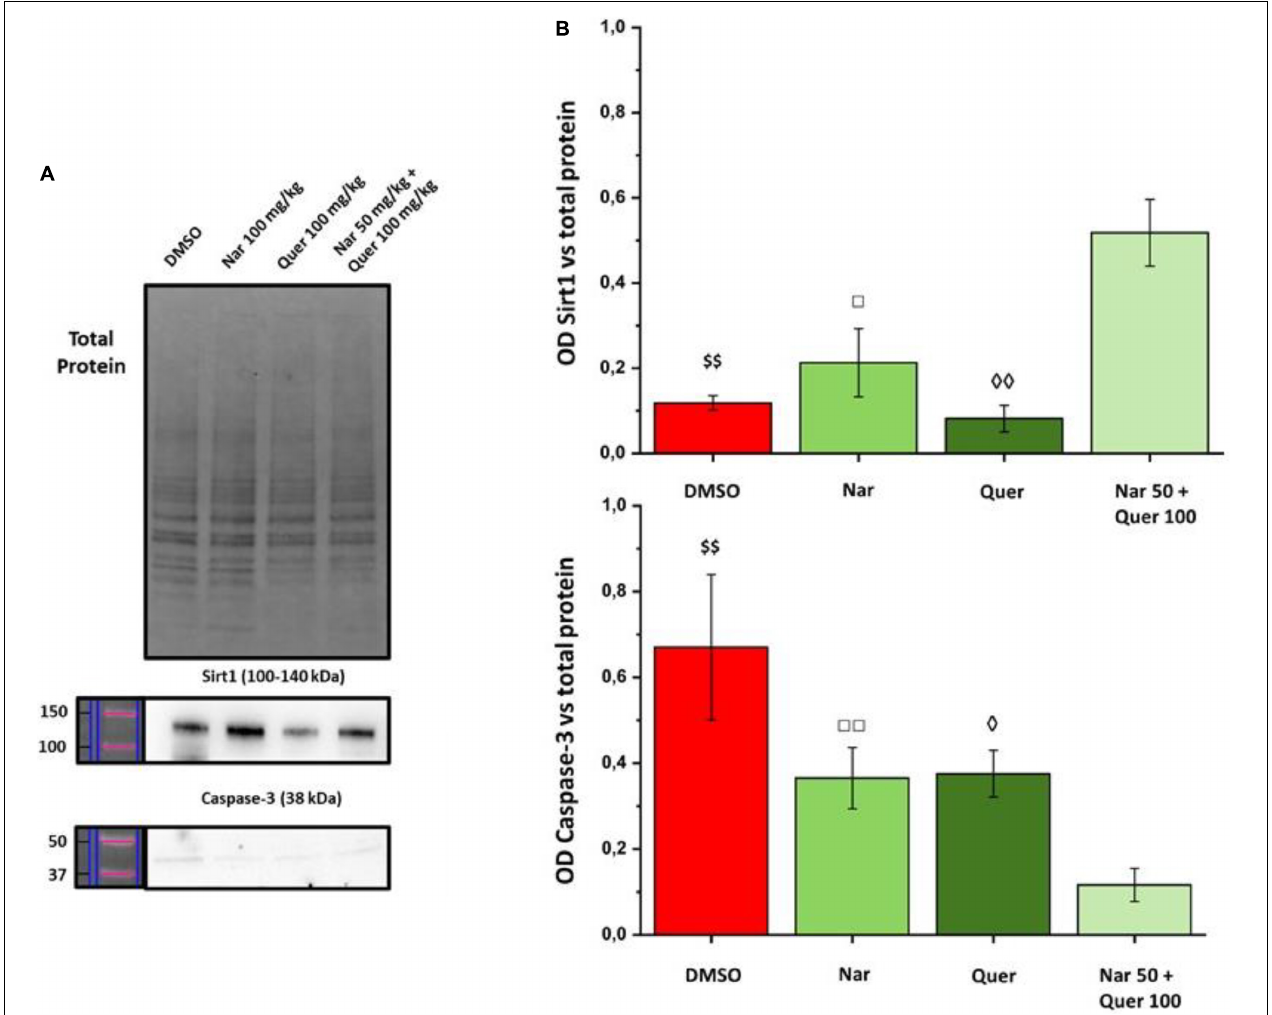
FIGURE 8 | WB analysis of apoptosis markers. (A) Image of the bands related to Total Protein, Caspase-3, and Sirt-1. (B) Histogram relative to the quantification, by optical densitometry, of Caspase-3 and Sirt-1. The number of animals used for WB analysis were, respectively: control group (DMSO, n = 6); naringenin 100 mg/kg/day ( n = 11); quercetin 100 mg/kg/day ( n = 6); naringenin 50 + quercetin 100 mg/kg/day ( n = 6). The data are representative of animals ± SEM. The bars represent each value normalized with the total protein and then compared with the control group (DMSO only); the statistical analysis was performed using